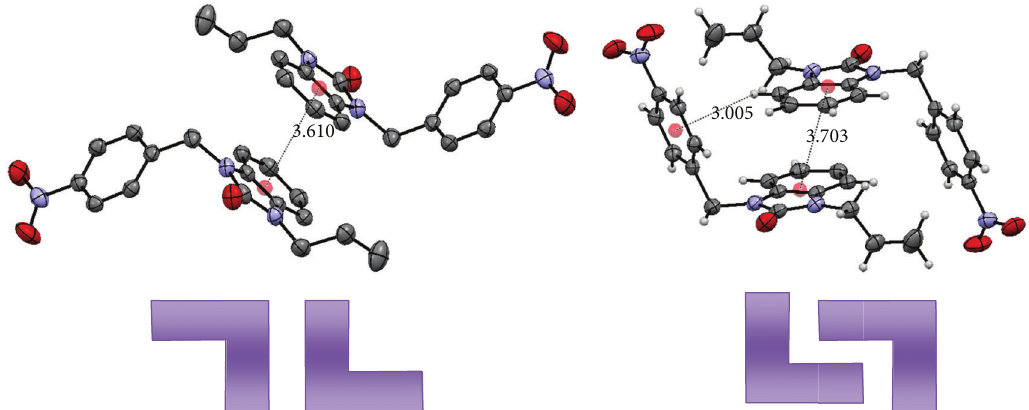
Figure 4: Intermolecular 1H-benzo[d]imidazol-2(3H)-one–1H-benzo[d]imidazol-2(3H)-one 𝜋 – 𝜋 interactions.